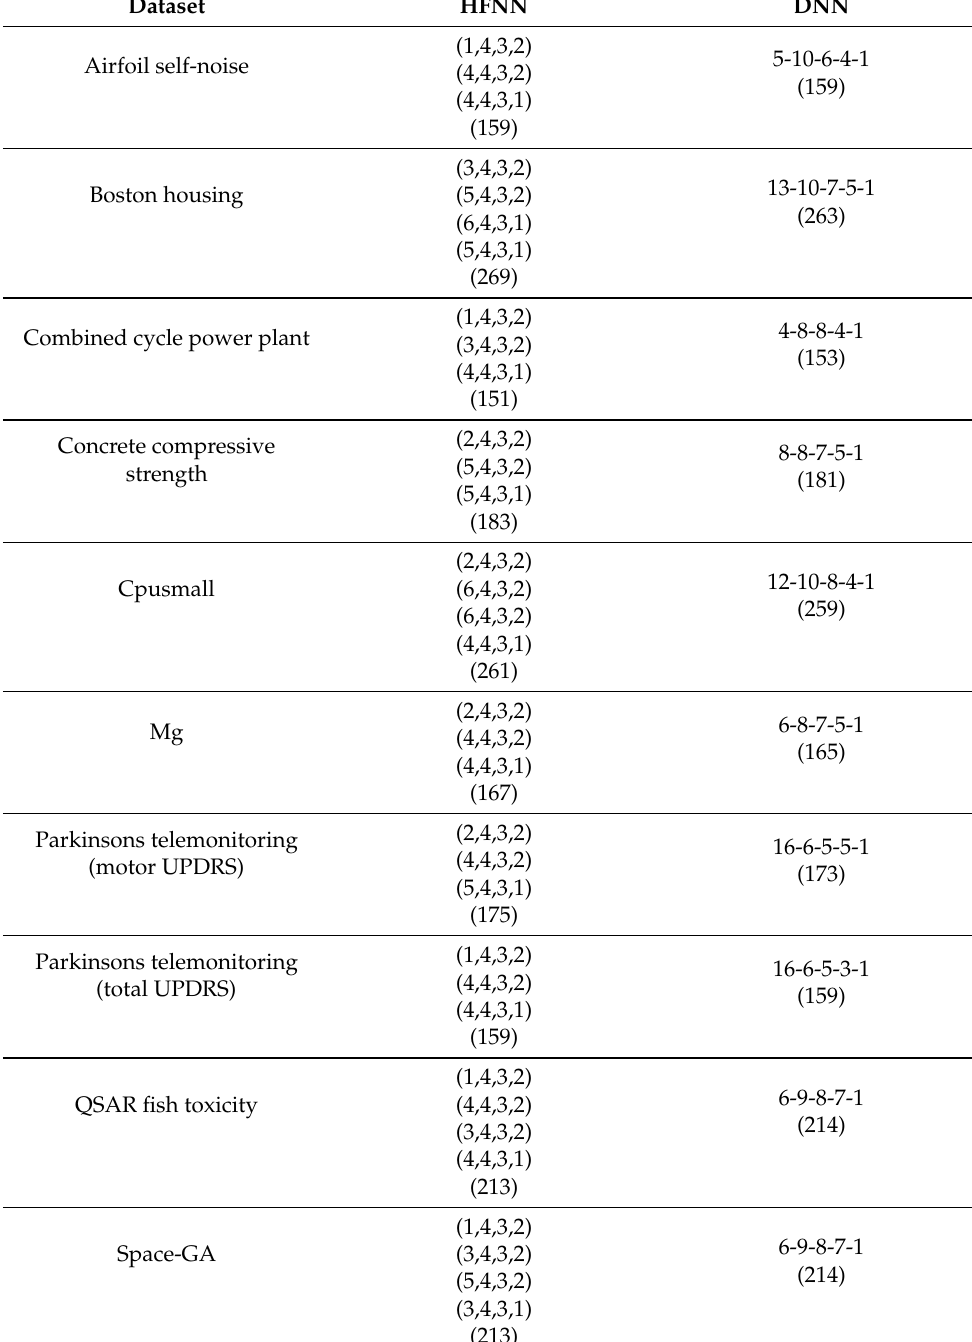
Table 2. Architecture of HFNNs and